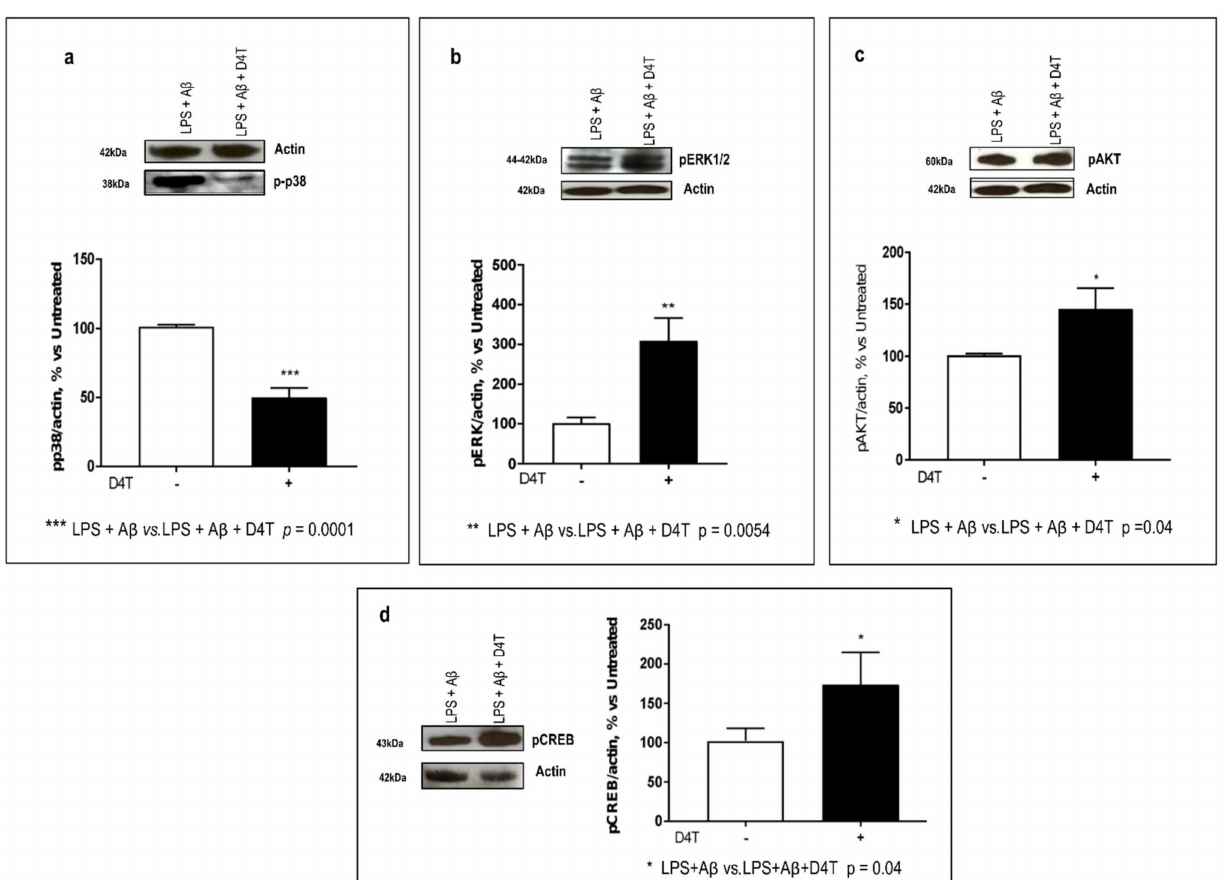
Figure 3. ERK1/2, p38, AKT, and CREB phosphorylation. The phosphorylation status of p38 (38 KDa) ( a ), ERK1/2 (42–44 KDa) ( b ), AKT (60 KDa) ( c ), kinases and CREB (43 KDa) ( d ) were investigated by Western blot analysis (WB) and each result was expressed as the percentage of ratio between phosphorylated-kinase and actin expression versus D4T-untreated cells (100%). Statistical significance is shown as (*** p < 0.0001, ** p < 0.001, * p < 0.05). Representative blots from independent experiments are shown in the upper part of panels ( a – d